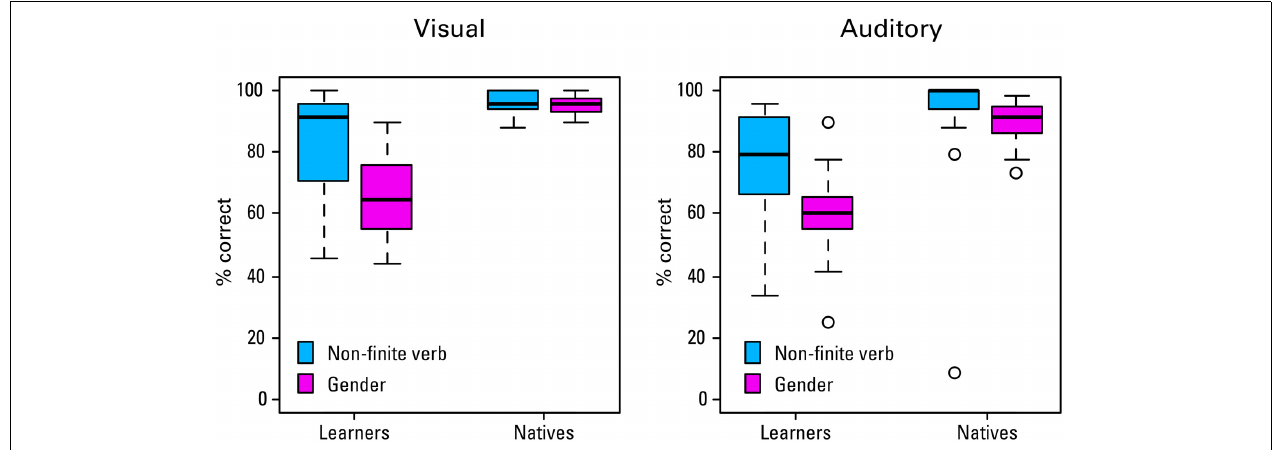
FIGURE 2 | Accuracy on grammaticality judgments made during ERP recording session by group, modality, and structure.